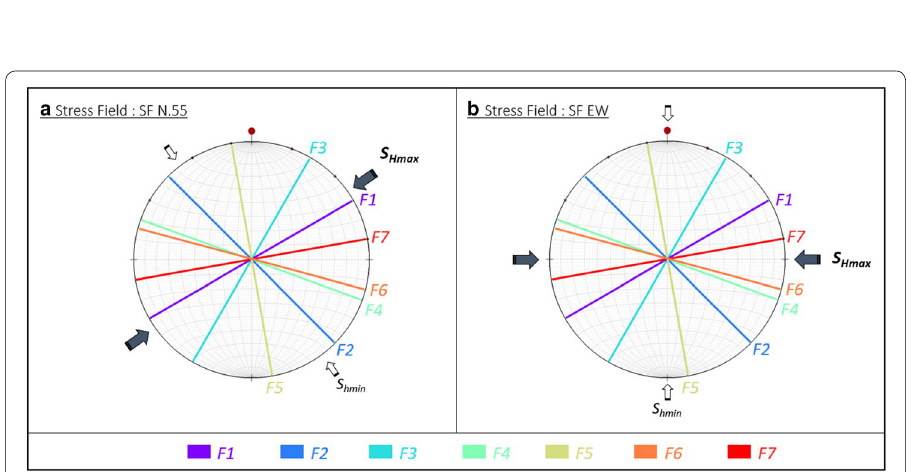
Fig. 1 Model implementation (from top to bottom): (cid:31) , the material properties; Ŵ , the DFMs; assignment of the stress field; well production scenarios